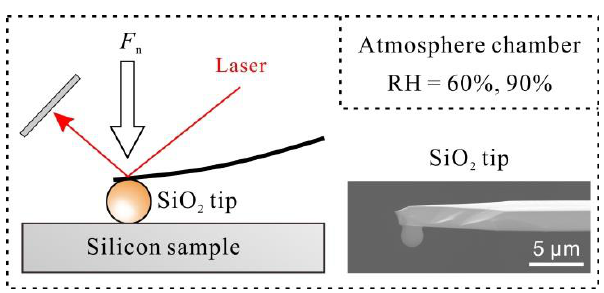
Figure 1. Illustration showing the wear tests of Si/SiO 2 pair by AFM in a humidity control